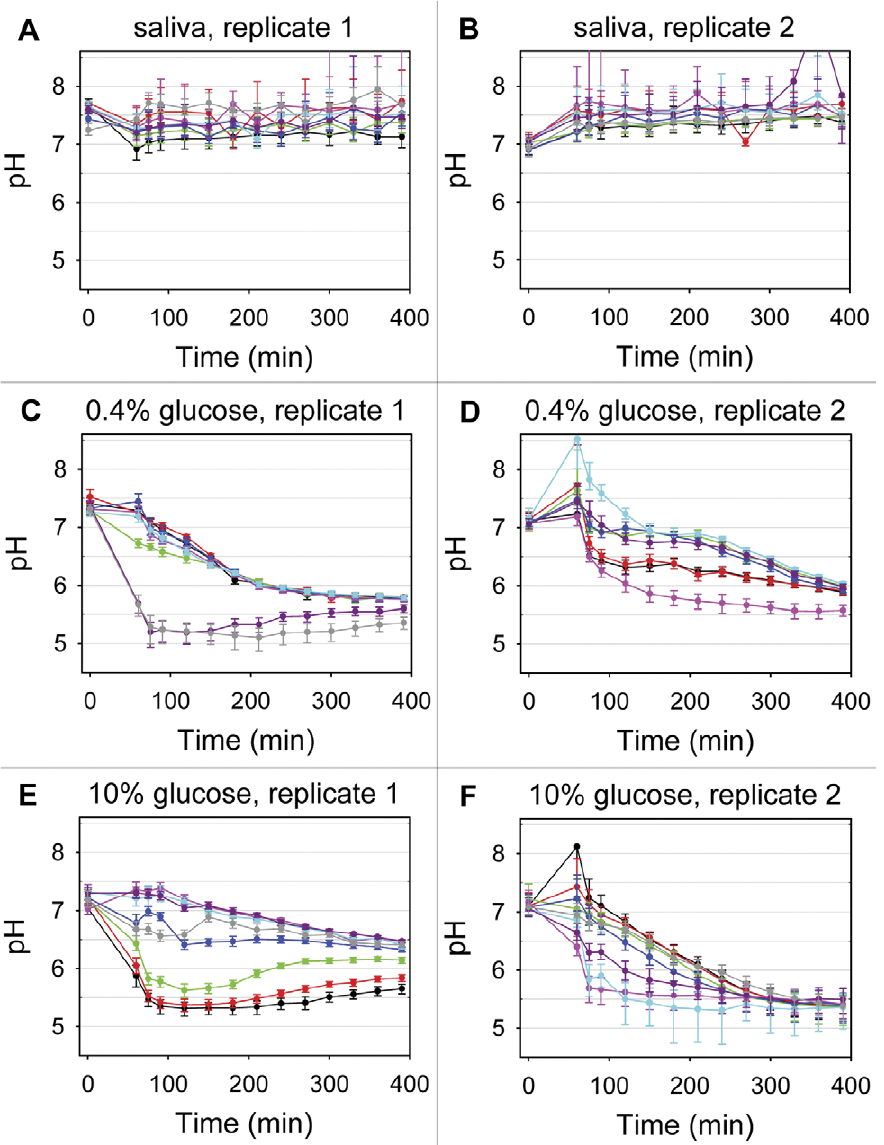
Figure 2. Extracellular pH in the model biofilms. Extracellular pH in the bottom layer of the biofilms was determined using the ratiometric probe C-SNARF-4 and confocal microscopy. In each biofilm, 8 different fields of view were monitored for 390 min. Each line graph represents the average pH in one field of view (143 m m 2 ). A and B : When exposed to saliva without glucose, extracellular pH in the biofilms remained continuously above 7. C , D , E and F : Upon addition of saliva containing 0.4% ( C and D ) or 10% glucose ( E and F ) (t=60 min), pH drops occurred in all examined microscopic fields. Decreases in pH varied considerably in different areas of the biofilms, and distinct pH microenvironments persisted for several hours. Error bars indicate standard